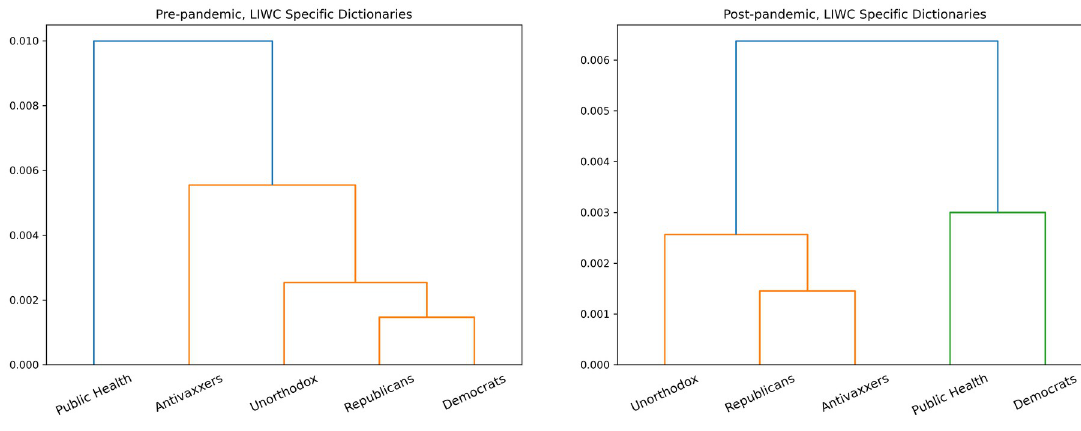
Fig 4. Dendrogram for LIWC-Specific